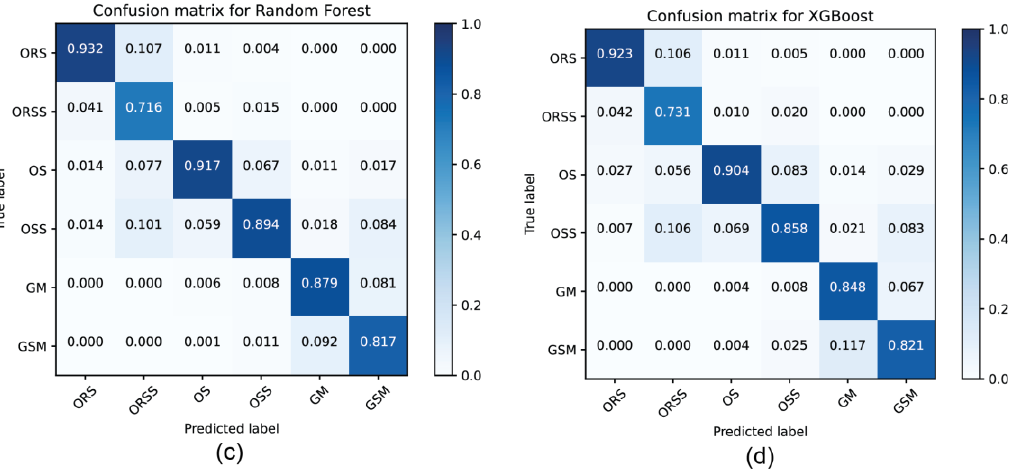
Figure 10. Confusion matrix of lithofacies prediction on test datasets by MLP ( a ), SVM ( b ), Random Forest ( c ), and XGBoost models ( d ). Refer to text for abbreviations of lithofacies.